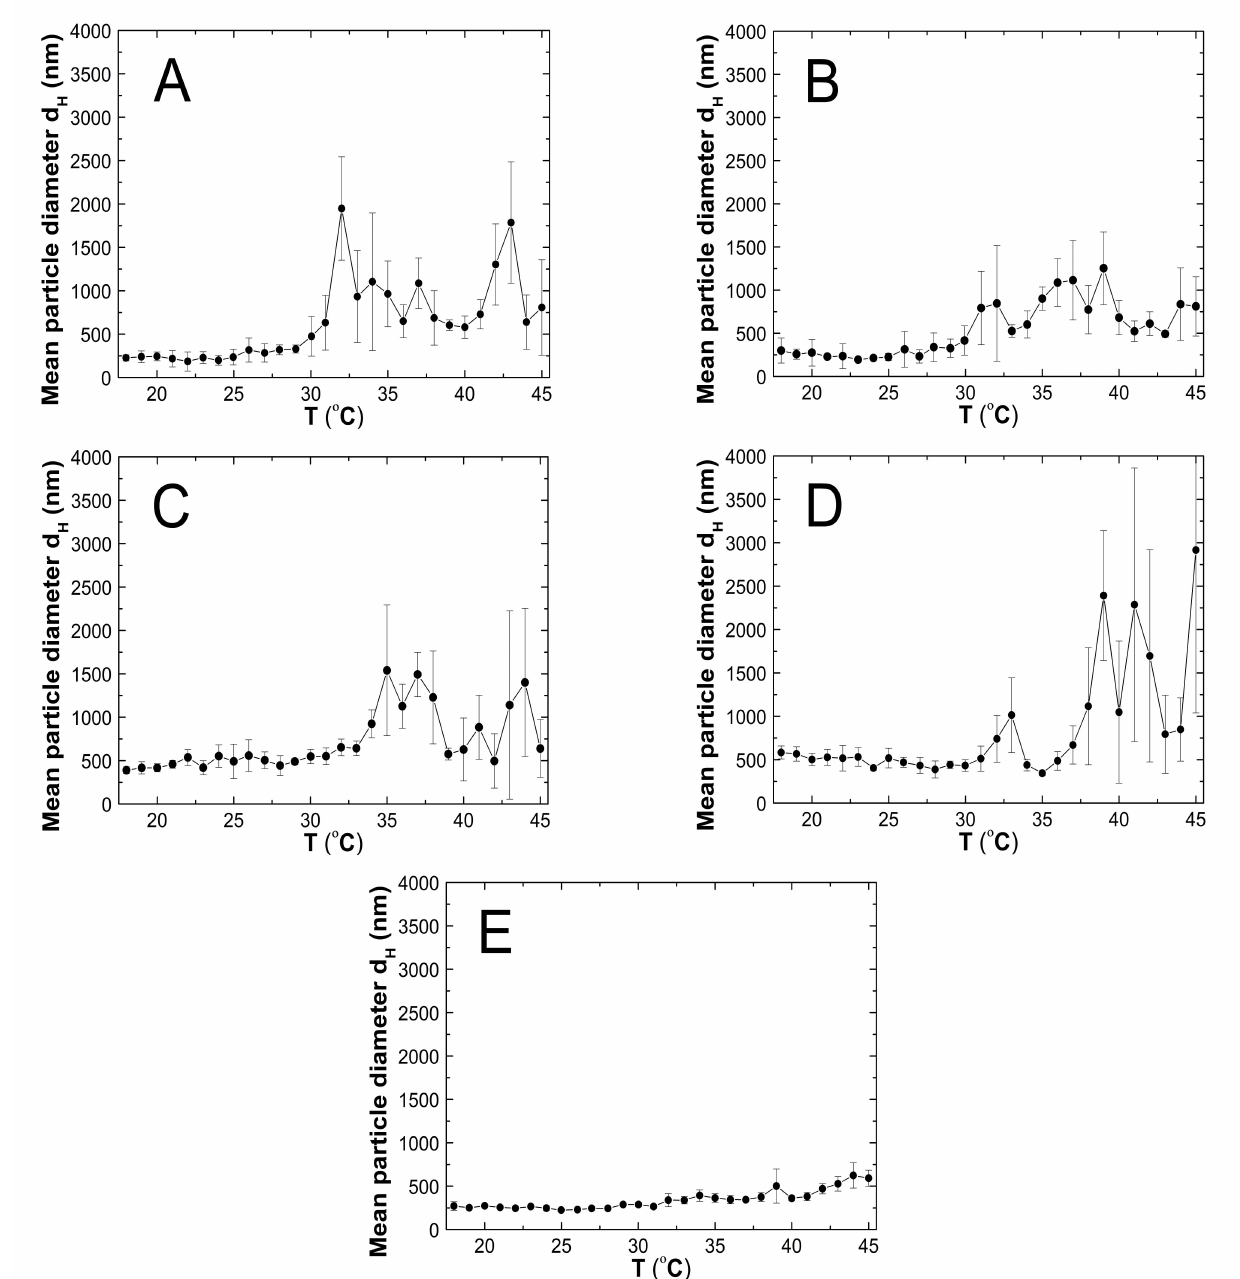
Figure 9. ( A – E ) The influence of temperature on the hydrodynamic diameter of the PS1 ( A ), PS2 ( B ), PS3 ( C ), PS4 ( D ), and PS5 ( E ) samples, determined by dynamic light